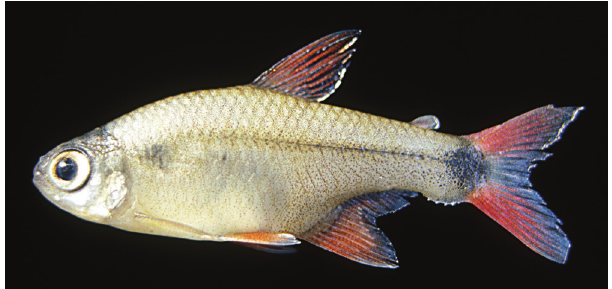
Fig. 5. Coloration just after preservation of Serrapinnus potiguar , adult male, approximately 25.0 mm SL, from the rio Ceará-Mirim, Rio Grande do Norte State,